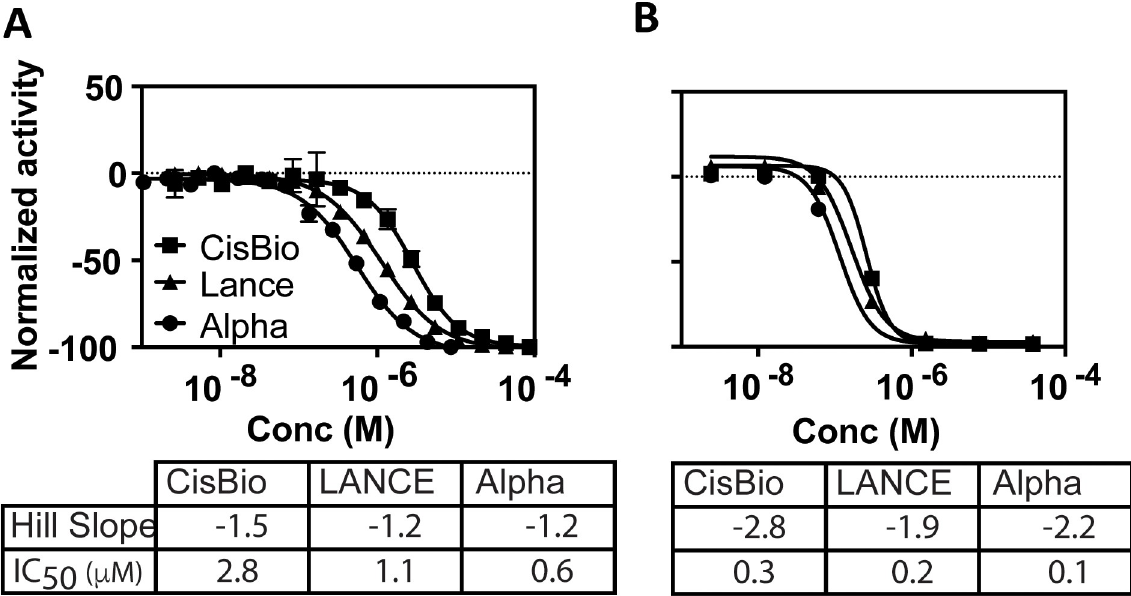
Fig 5. Validation of assay specificity and performance. (A) Assay specificity was validated using SIRP α -cold titrated to inhibit the CD47-binding activity of SIRP α -biotin in the screening assays. Hill slope and IC 50 are indicated (n = 4). (B) Assay performance using a positive control small molecule (biotin) was assessed in all three assays (n = 1). Normalized activity calculated with neutral control (+CD47, +SIRP α , no inhibitor) as 0% and low control (-CD47 +SIRP α , no inhibitor) as -100% activity. Assay activity with tested agents was then compared and normalized to these